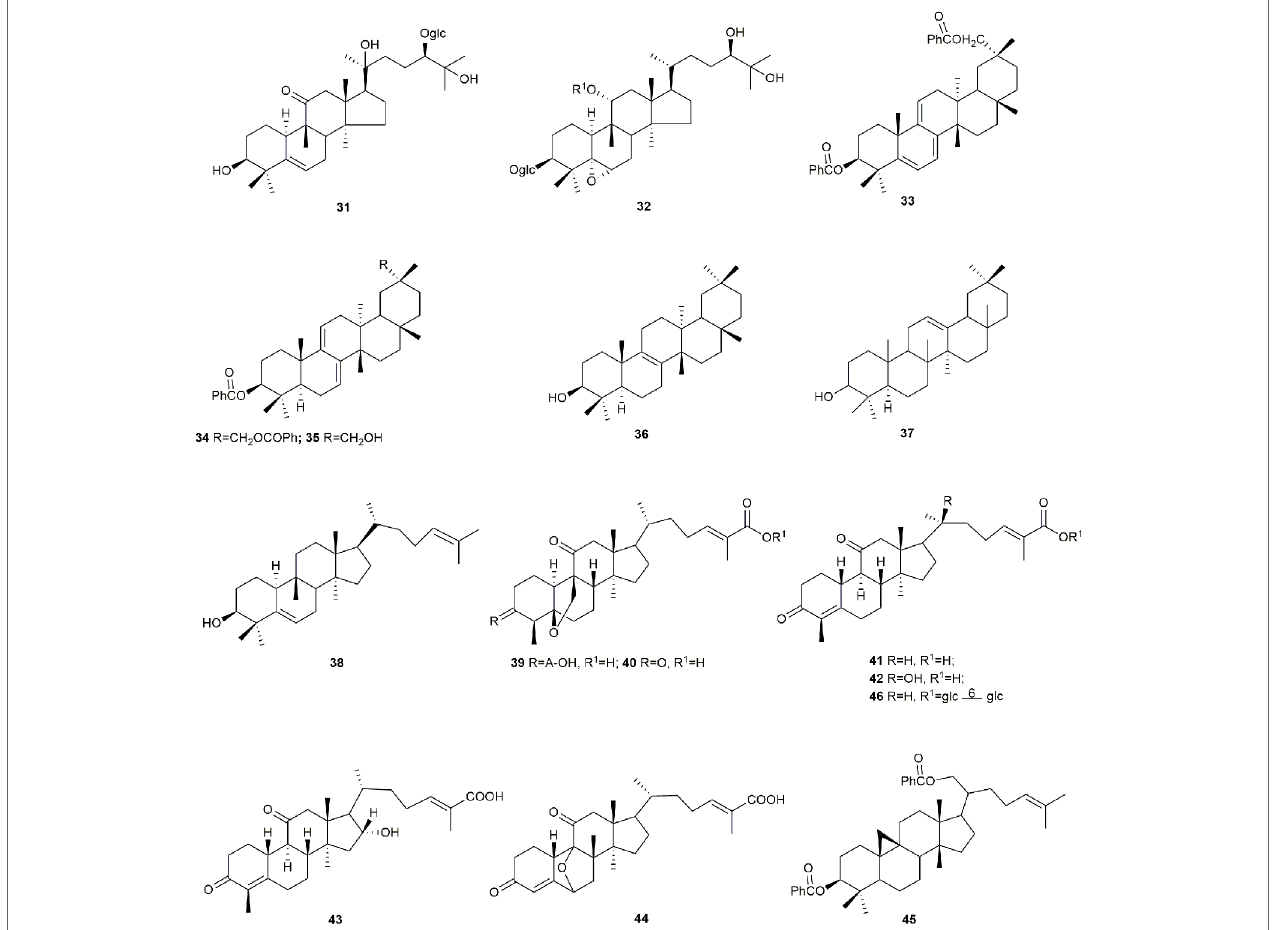
FIGURe 3 | The structures of the triterpenoid compounds isolated from S. grosvenorii .